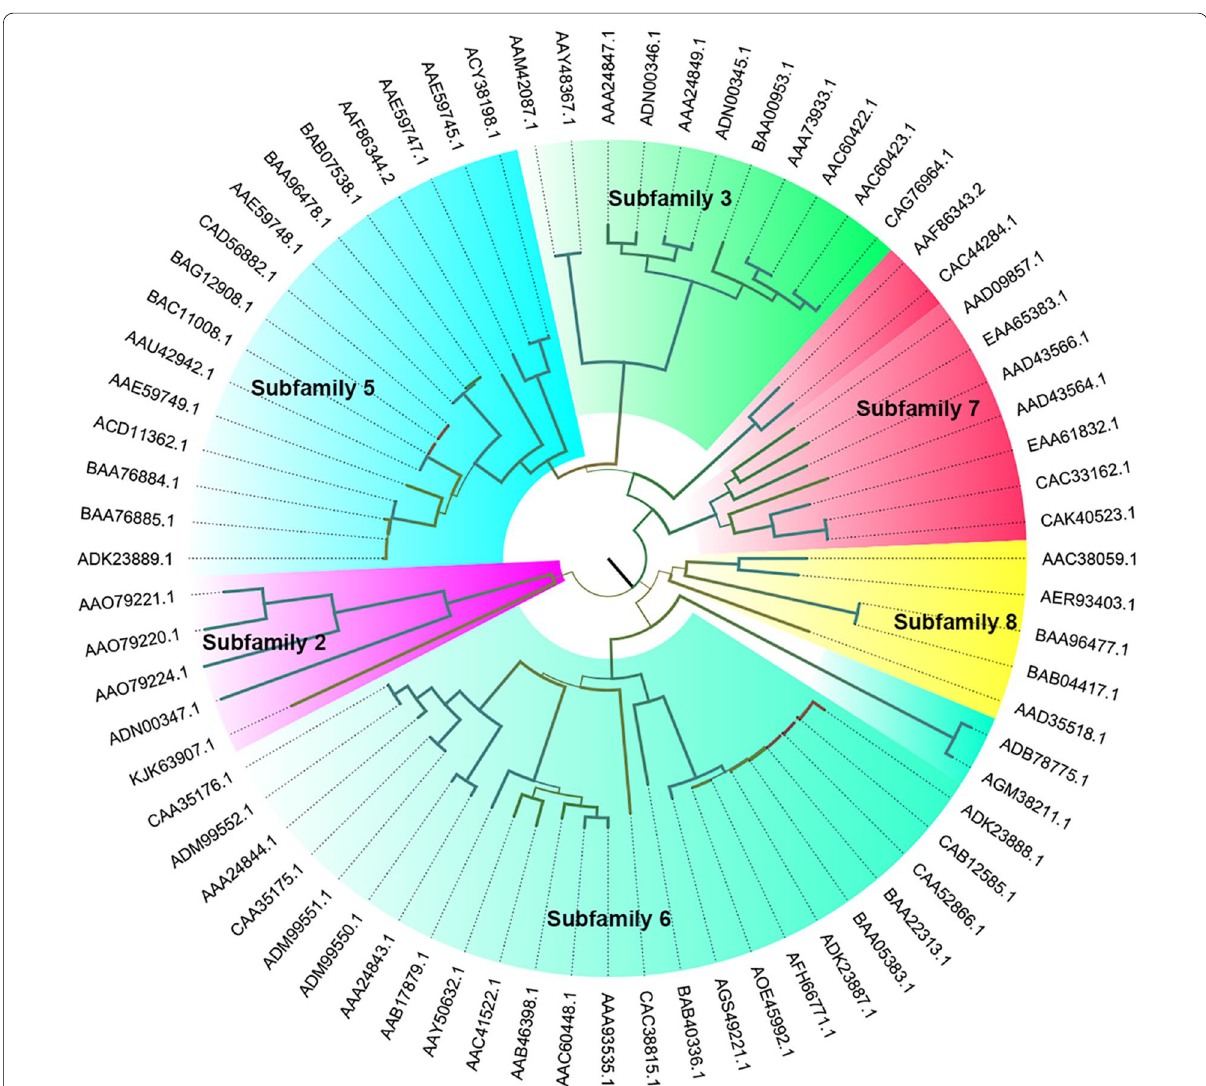
Fig. 2 Phylogenetic analysis of PGLs from the PL1families. Different color blocks represented different subfamilies of PL1 family, respectively. Light purple: subfamily 2, bright green: subfamily 3, bright blue: subfamily 5, celeste: subfamily 6, yellow: subfamily